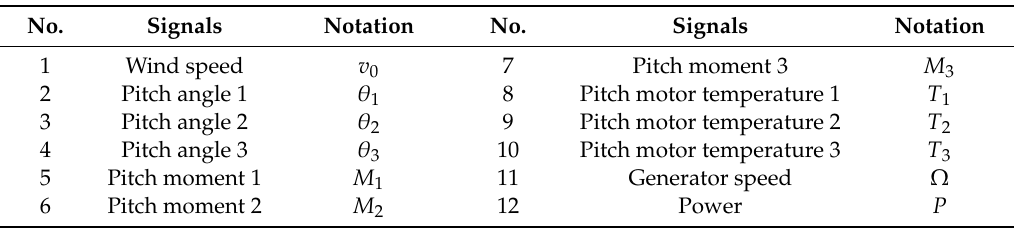
Table 1. Description of wind turbine pitch system signals.